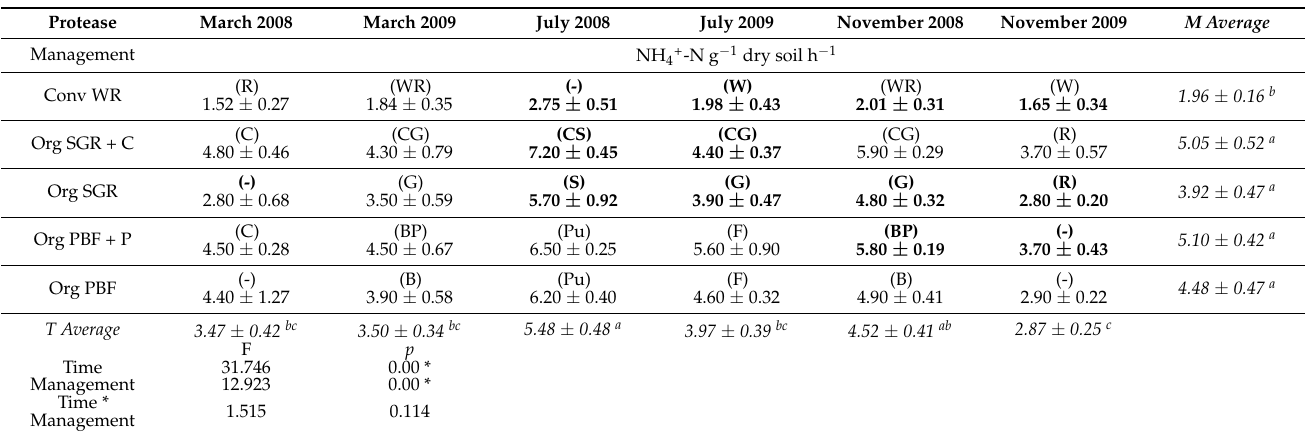
Table 8. Protease enzymatic activity in soil.